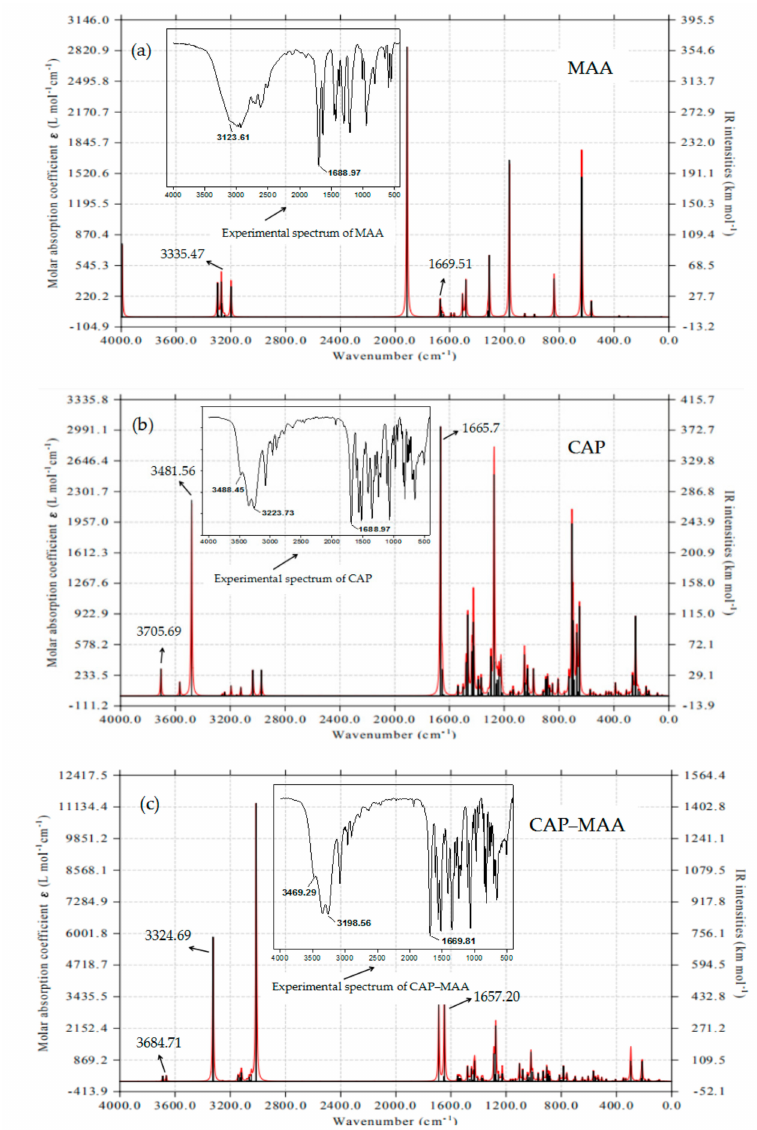
Figure 7. Theoretical and experimental fourier transform infrared spectroscopic (FTIR) of ( a ) functional monomer MAA, ( b ) template CAP, and ( c ) CAP–MAA